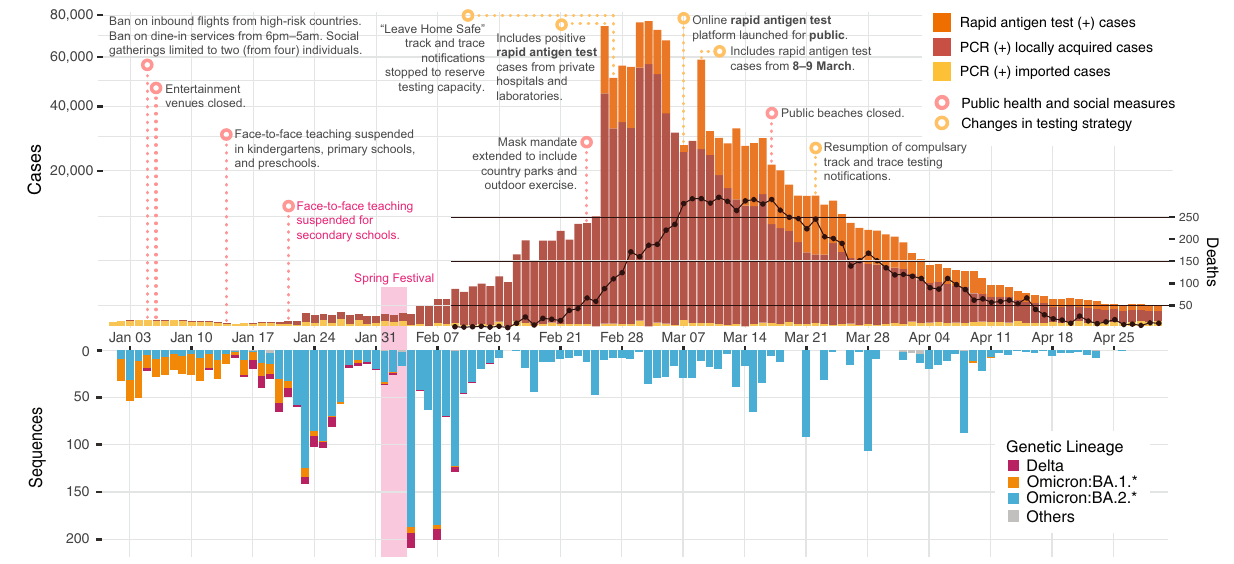
Fig. 1 | Epidemiological summary of SARS-CoV-2 from January to April 2022 in Hong Kong. Reported cases and deaths (above) and sequenced genomes (below)